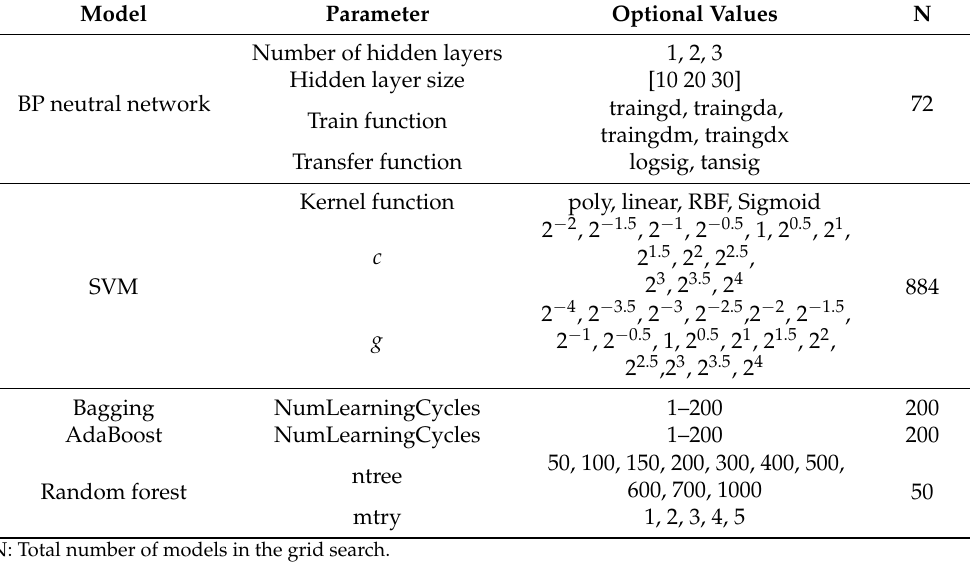
Table 2. Optional parameter values in grid search.